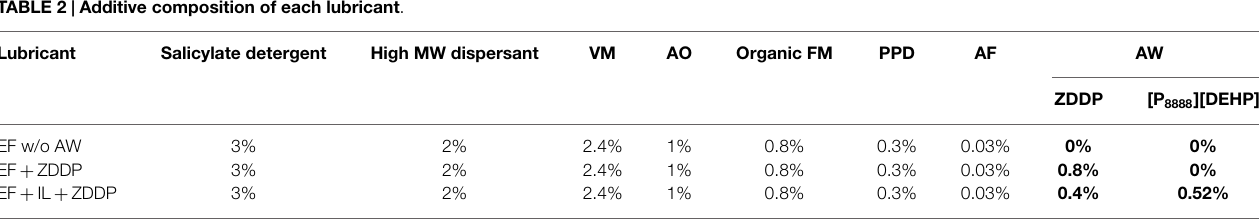
Percentages are on a mass basis. TABLE 3 | Density, P and Zn content, viscosity index, and rheological data for each lubricant . Lubricant Density (g/cm 3 )